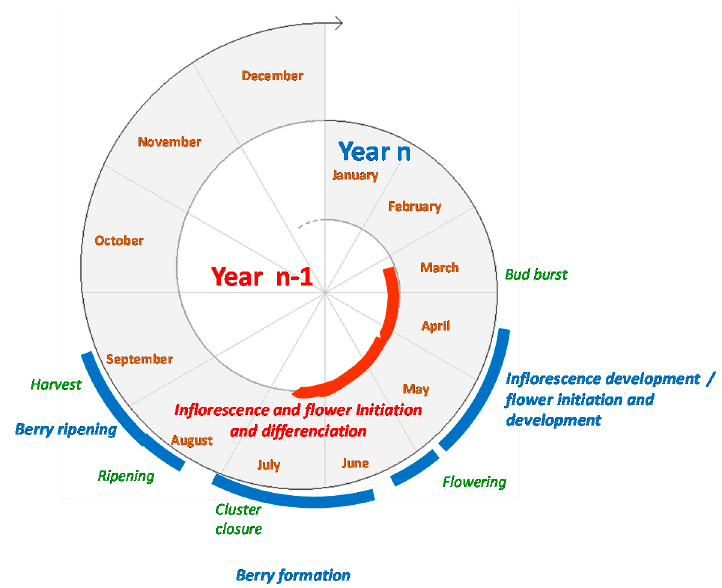
Figure 1. Grapevine yield elaboration over two years: Processes are noted in bold italics (red for year n − 1 and blue for year n ) and phenological stages in green italics.